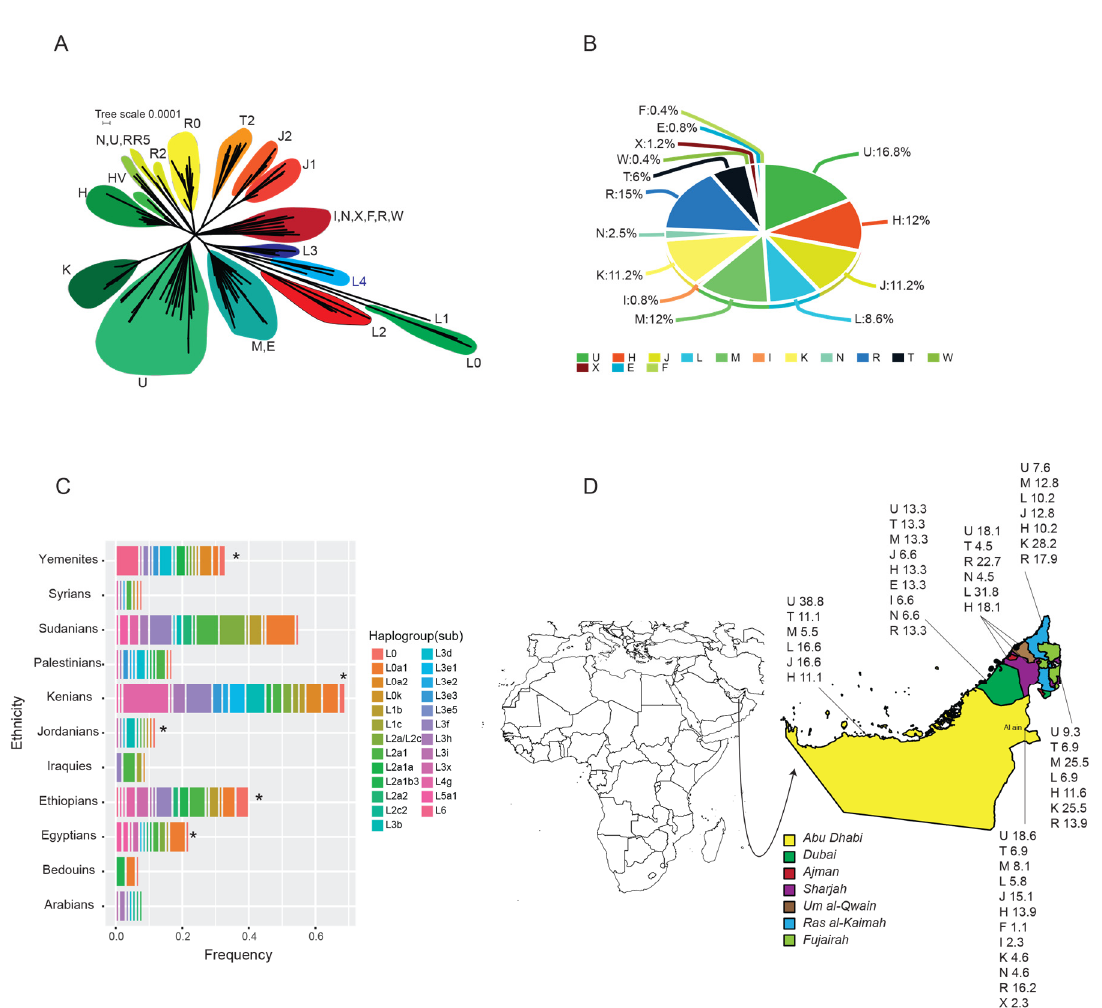
Figure 2. Haplogroup distribution and frequency. ( A ) Network haplogroup tree depicting the ancestral (L) haplogroups and the out of Africa haplogroups. ( B ) Total haplogroup frequencies for the UAE population. ( C ) Stacked bar plots for the frequencies of L3 haplogroup from di ff erent Levant and African countries. Stars highlight the presence of L3x1b sub-haplogroups in these countries. ( D ) A map of Africa and the Arabian Peninsula and a zoom on the UAE map with highlights of the di ff erent haplogroup frequencies for the di ff erent cities of the UAE.